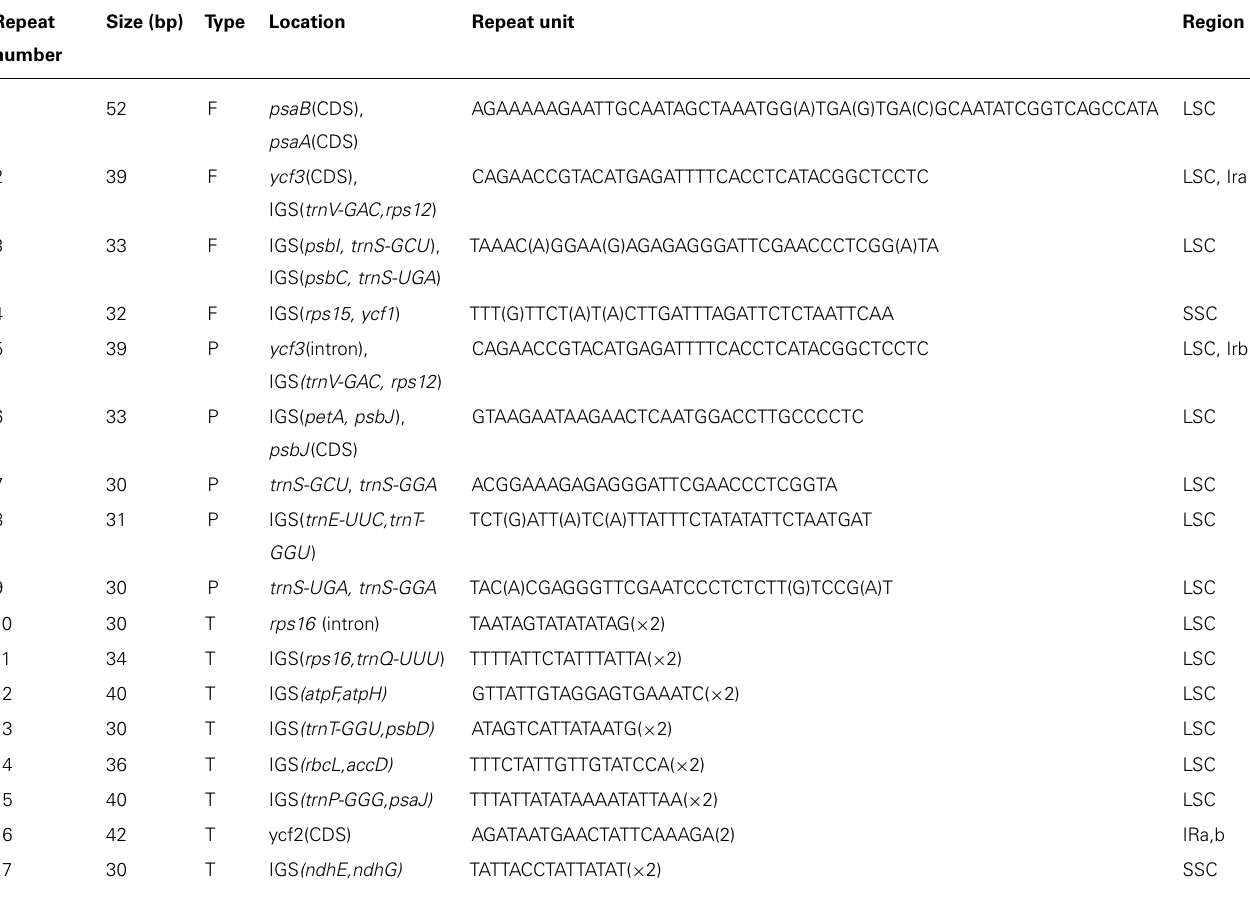
Table 5 | Repeated sequences in the A. barbatum var. puberulum chloroplast genome.